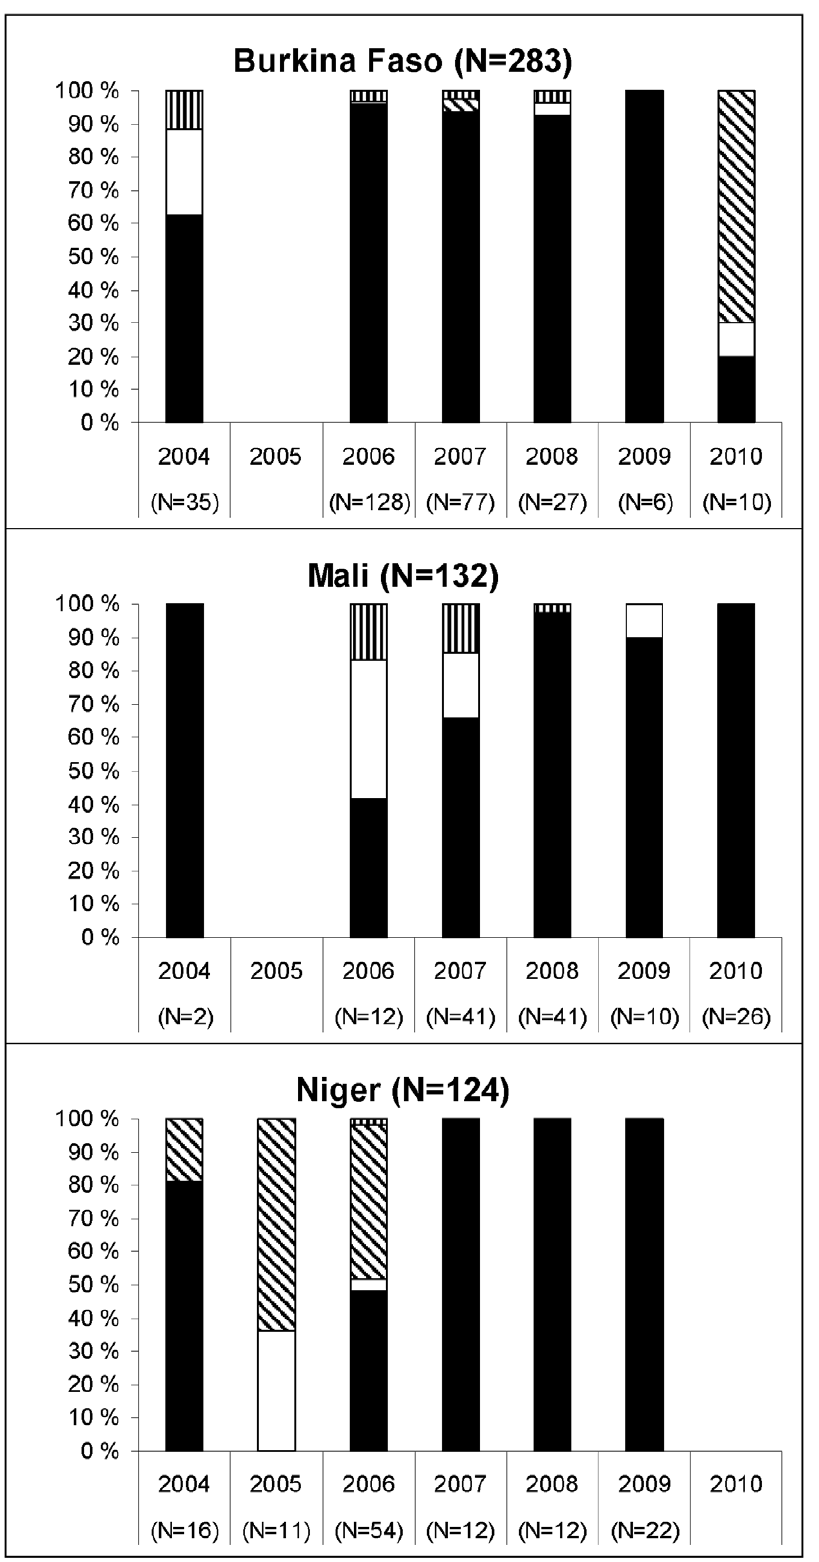
Figure 1. Serogroup distribution (%) in Burkina Faso, Mali and Niger in the period 2004–2010. In the figure, the few non-groupable isolates were included together with those assigned to a serogroup on the basis of the capsule PCR and/or their molecular profile, except for ST-192 isolates (n=2) that were likely to harbour a capsule null gene [36]. Black bars: serogroup A; white bars: serogroup W135; oblique strips: serogroup X; vertical strips: serogroup Y. doi:10.1371/journal.pone.0046019.g001 PLOS ONE |